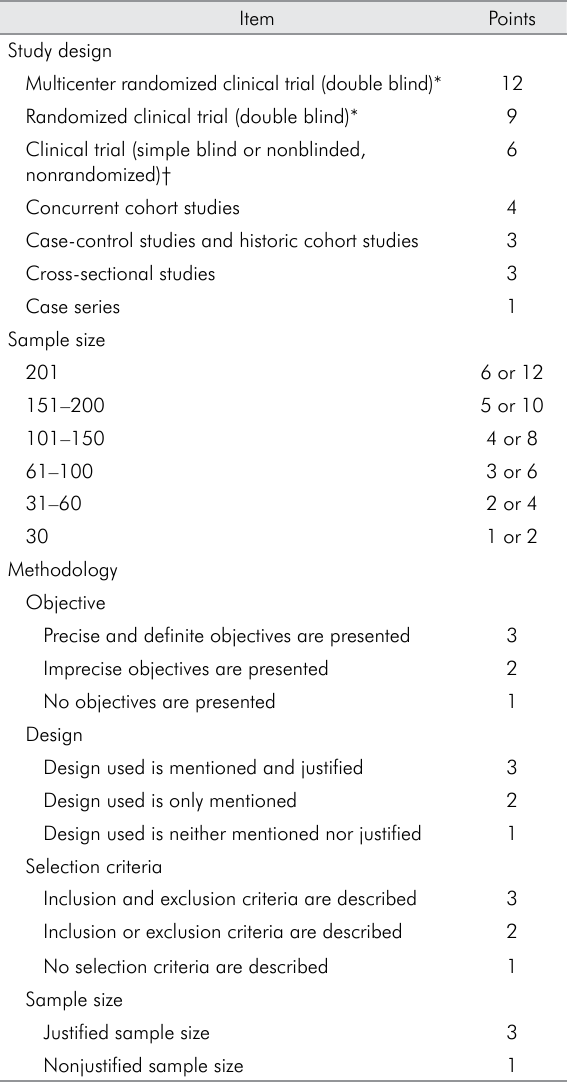
Table 1. MINCIR scale item scoring (adapted from Man-